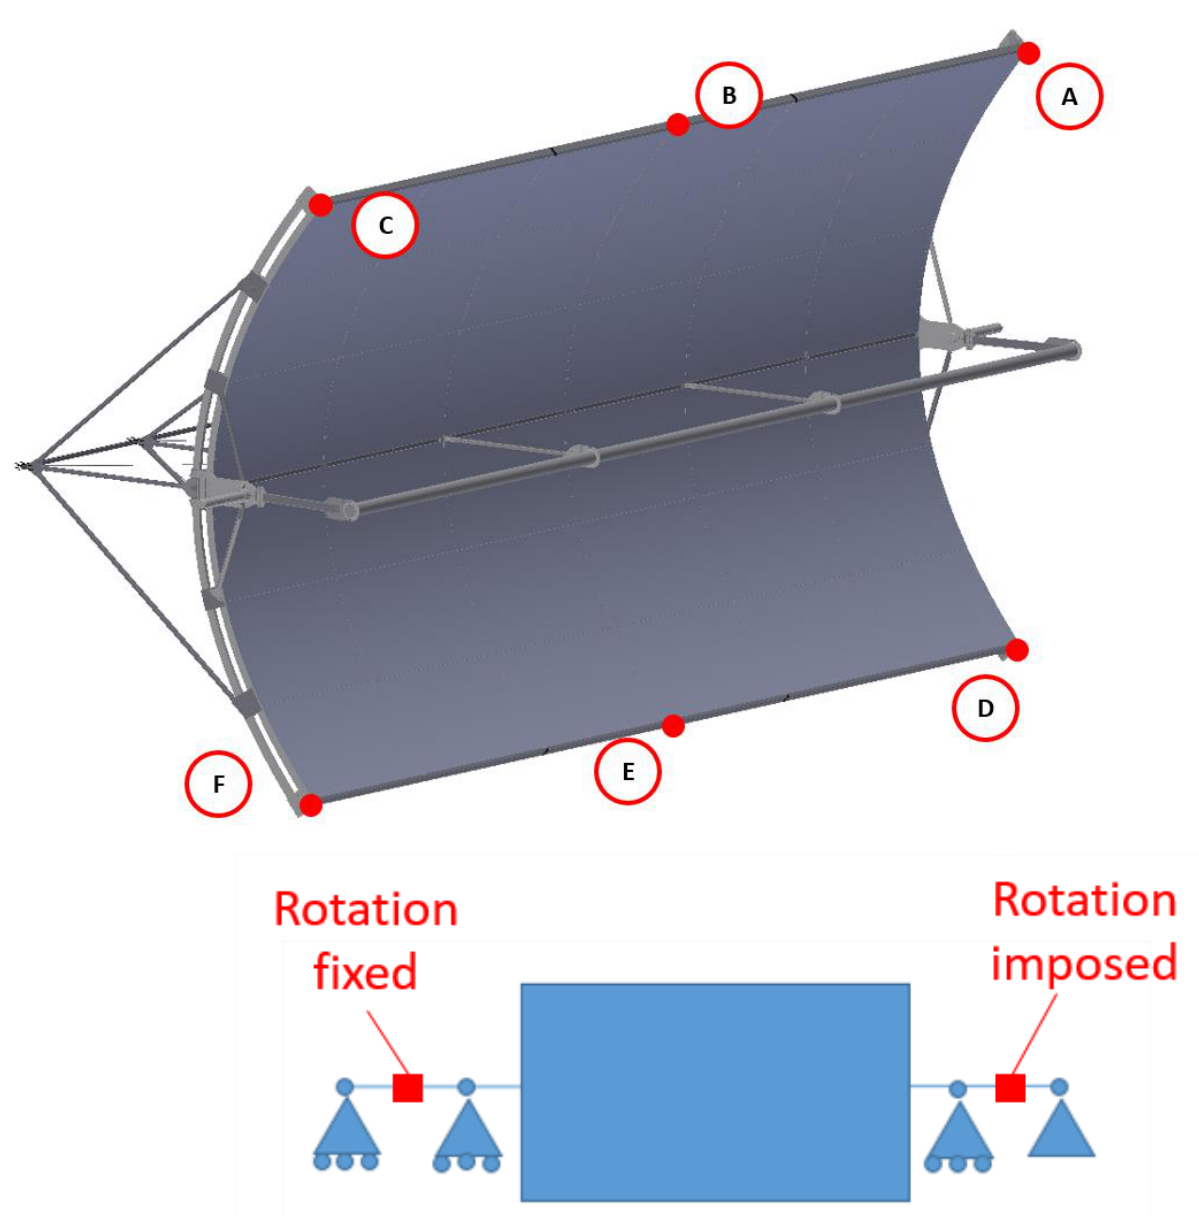
Figure 8. Sensor position is depicted in the upper figure whereas boundaries applied in the differential torsion model are reported in the lower figure.